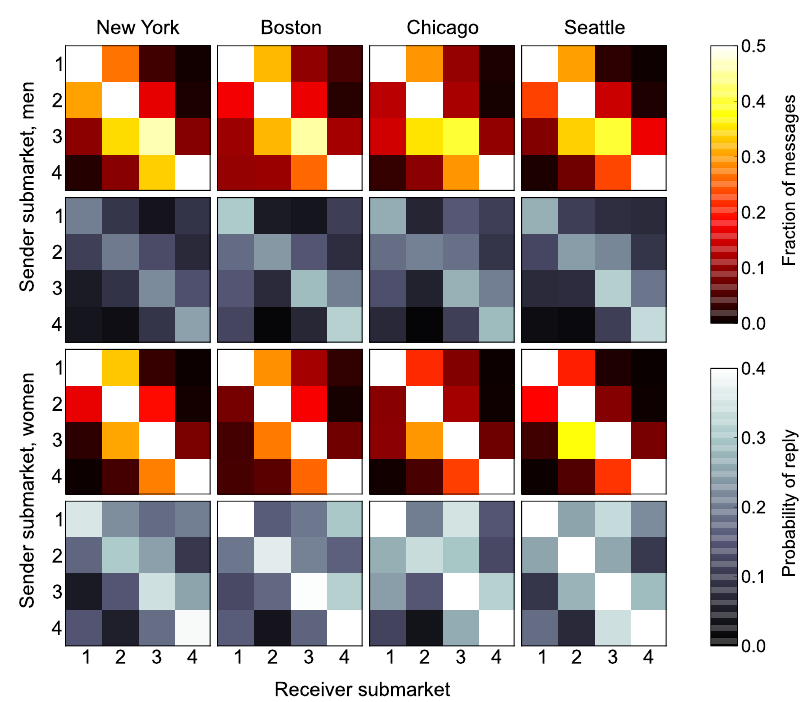
Figure 4: Fractions of messages sent, and fraction that receive a reply, for messages from men to women (top two rows) and women to men (bottom two rows) in each of the four cities studied. Brighter colors indicate larger numbers of